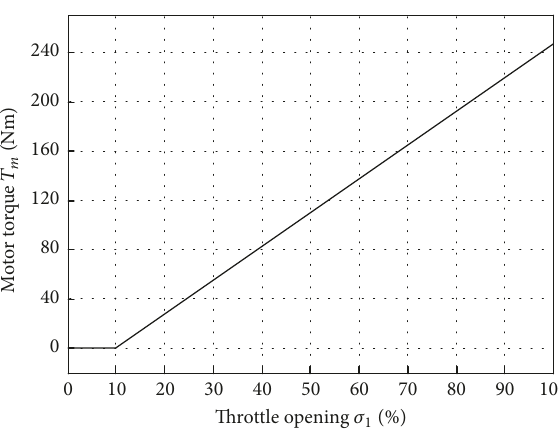
Figure 11: Throttle opening and motor output torque curve.